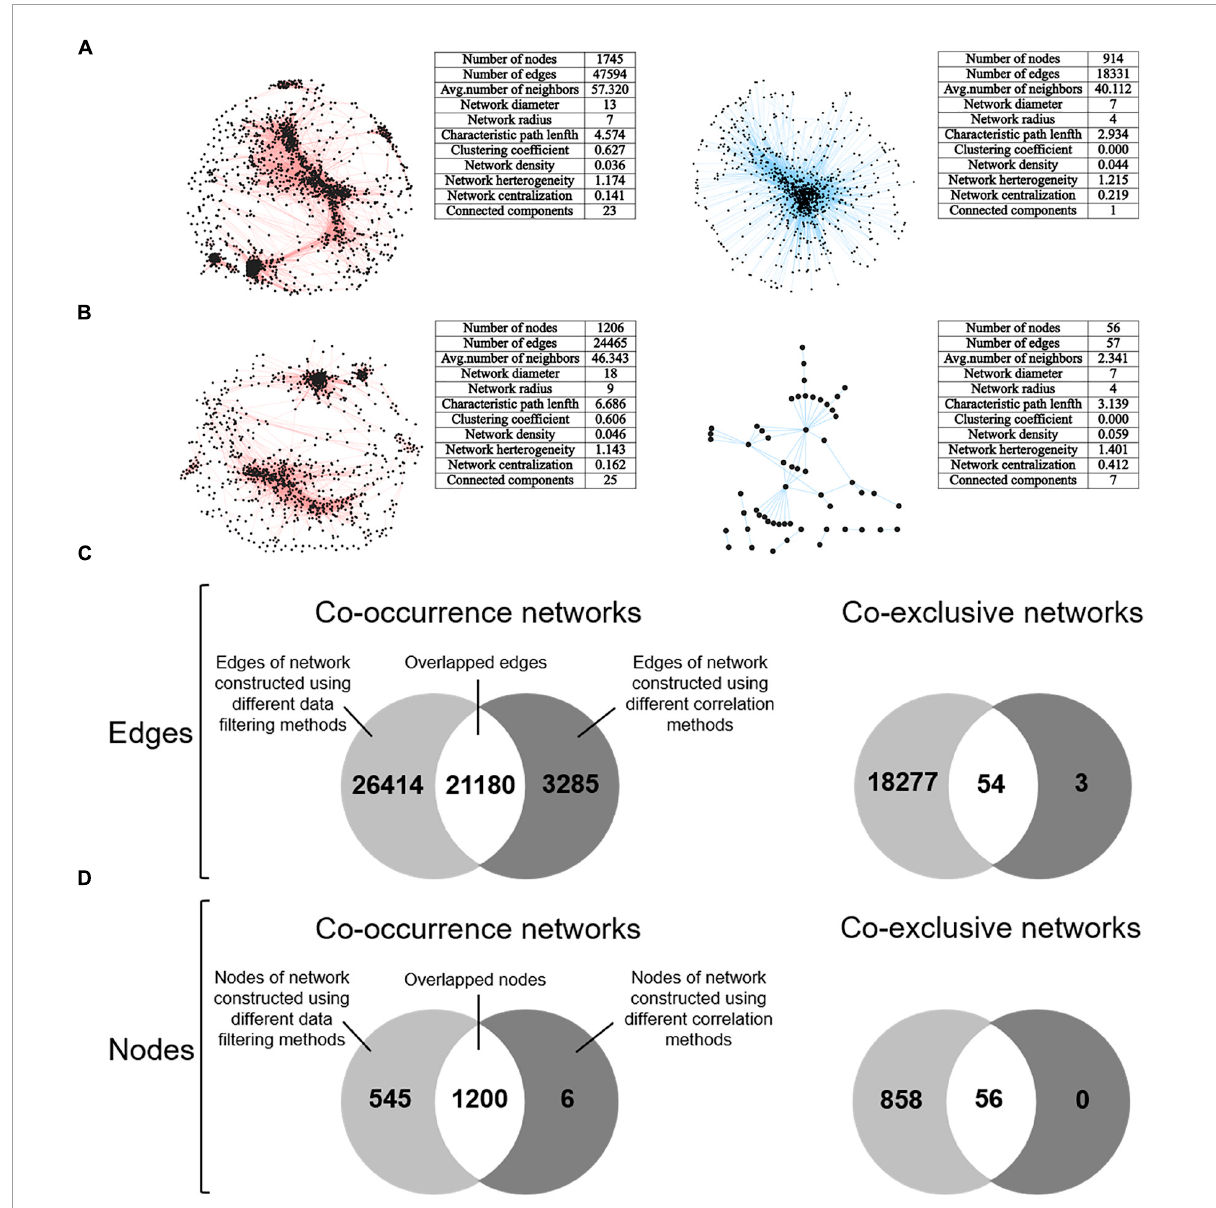
FIGURE5 Consensus networks representing microbial co-occurrence and co-exclusive associations were constructed and comparatively analyzed. (A) Consensus co-occurrence and co-exclusive networks constructed by extracting the overlapped nodes and edges based on networks constructed using the first, third, fifth, and sixth data filtering method (refer to Figure 1 ). The Spearman’s rank order correlation coefficient was used for network construction. (B) Consensus co-occurrence and co-exclusive networks constructed by extracting the overlapped nodes and edges based on networks constructed using different correlation methods, including Spearman, Pearson, Kendall, and SparCC. The first data filtering method (filling missing values with zero) was used here. (C) Overlapped edges between the consensus networks of different data filtering methods and correlation methods. (D) Overlapped nodes between the consensus networks of different data filtering methods and correlation methods. In panels (A,B) , networks with red edges represent co-occurrence networks, and networks with blue edges represent co-exclusive